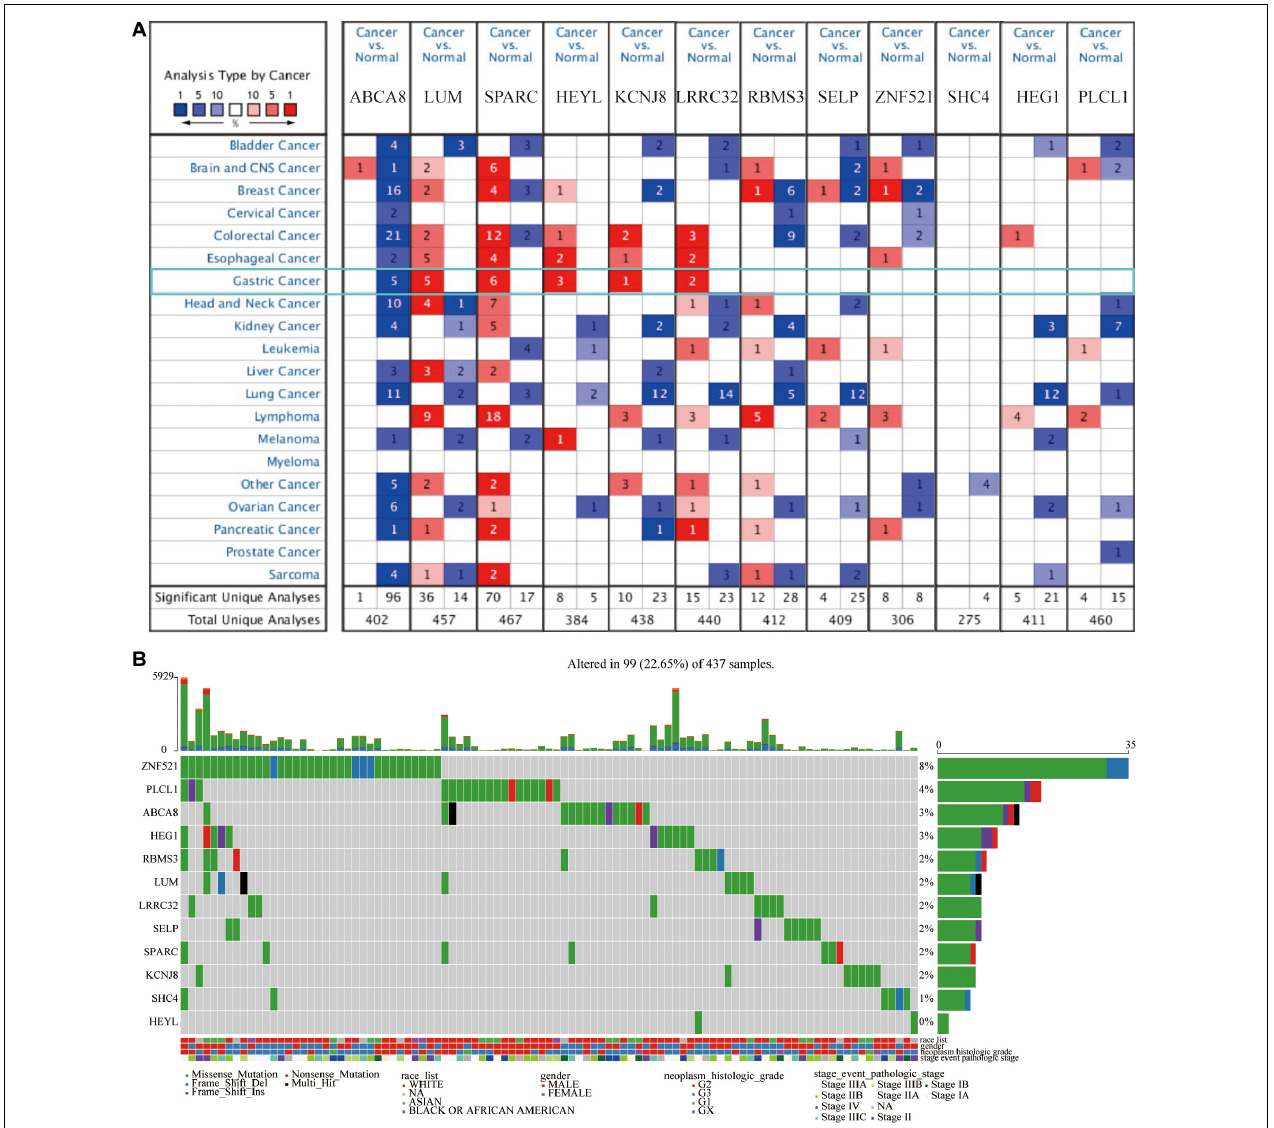
FIGURE 4 | Twelve candidate genes expression and mutation analysis. (A) Transcriptional expression of 12 candidate genes in pan-cancer on the ONCOMINE database. (B) Mutation analysis of 12 candidate genes in TCGA-STAD